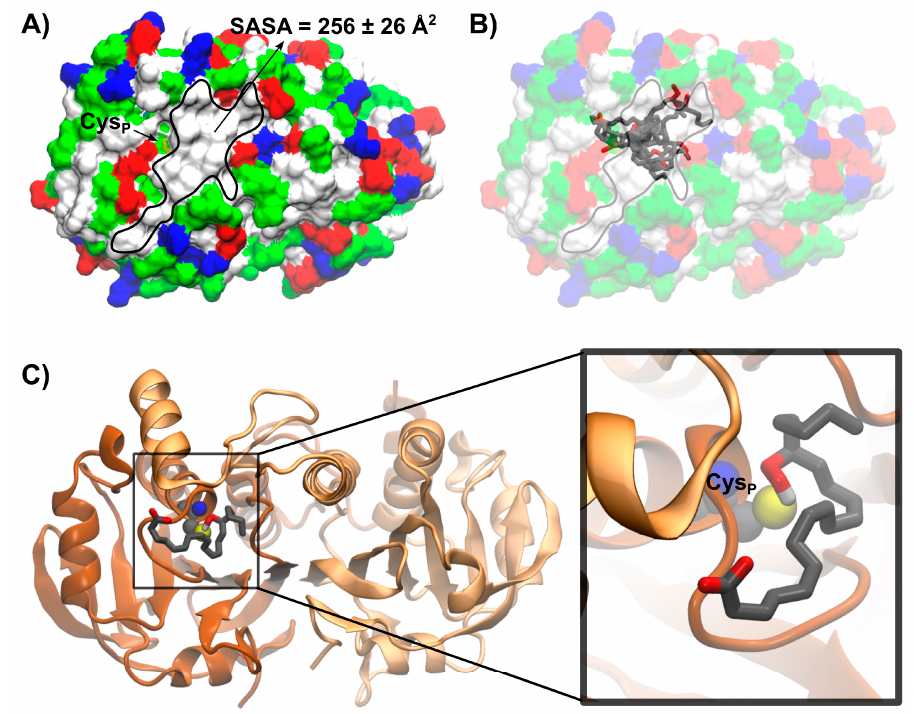
Figure 7. Best ranked structures of the binding of 15(S)-HpETE to Hs Prx3 obtained by docking simulations. ( A ) Surface representation of Hs Prx3 dimer colored by amino acid properties: white, hydrophobic; green, polar; blue, basic; red, acidic. The hydrophobic patch close to Cys P is highlighted and the solvent accessible surface area (SASA) value measured during the MD simulation is shown. ( B ) Superimposed 15(S)-HpETE representative structures of the ten best ranked clusters with at least five structures obtained by molecular docking. Hydrogen atoms are not shown for simplicity. ( C ) Representative structure of the most populated best ranked cluster from the molec-